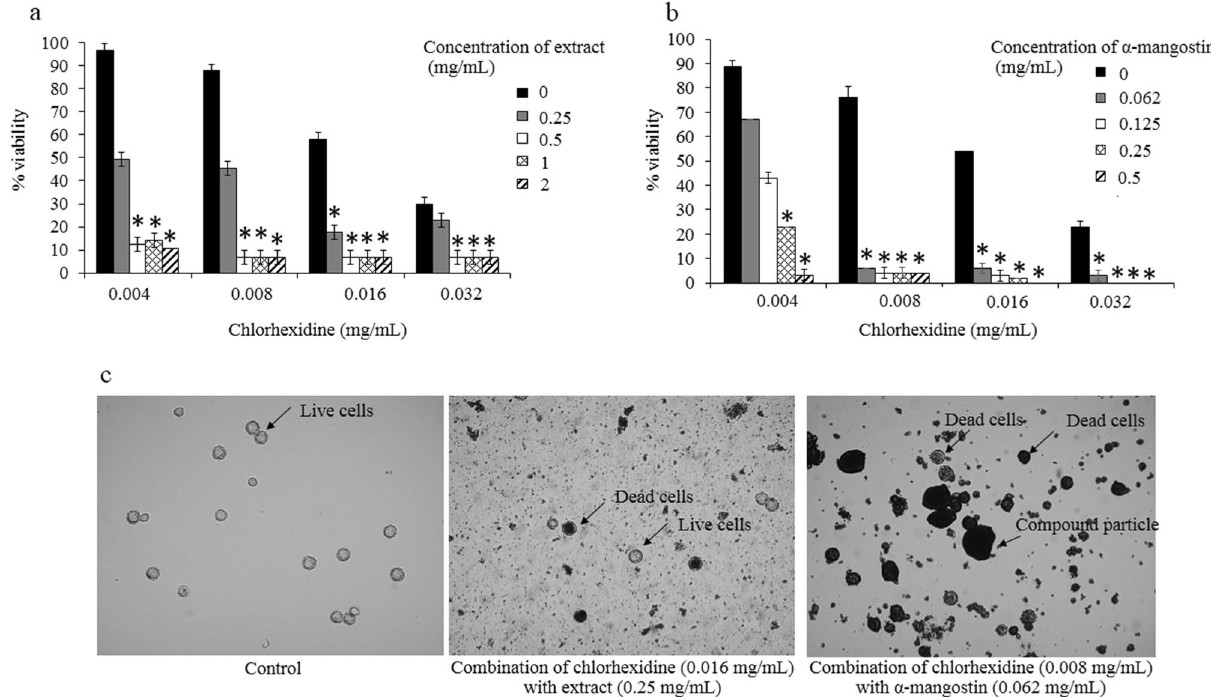
Figure 5. Combination of G. mangostana extract or α-mangostin with chlorhexidine for anti-amoebic effects on cysts of A. triangularis. Parasites were grown in PYG medium in the presence of chlorhexidine alone and combination with G. mangostana extract ( a ) or α-mangostin ( b ) for 24 h. The inhibitory activity was carried out using trypan blue exclusion assay; 1% DMSO was used as a negative control ( c ). Treated cysts were observed under inverted microscopy (40x). The relative percentage of viability was defined as (mean of the treated /mean of the control) × 100. * p < 0.05, statistically significant difference in combination to single drug